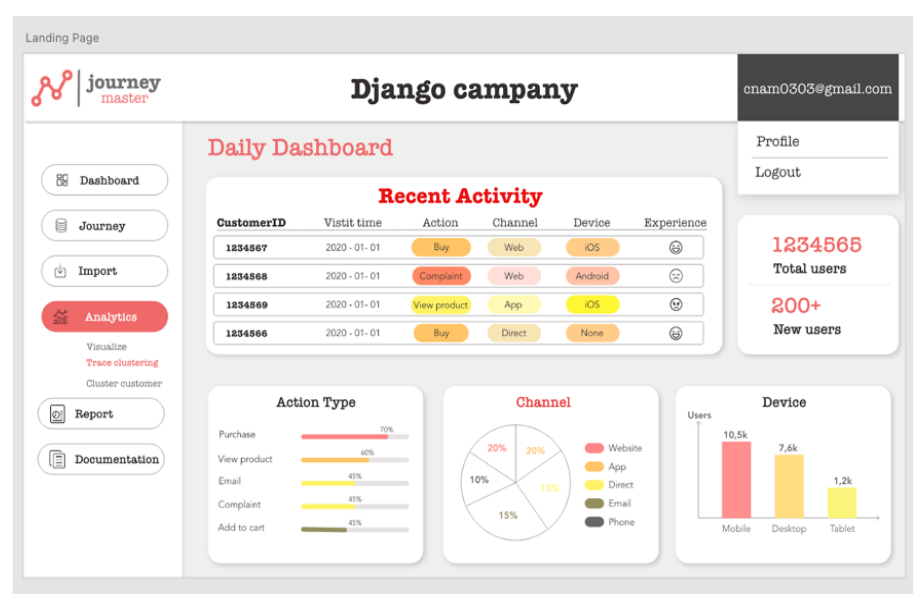
Fig. 5. Knowledge processing